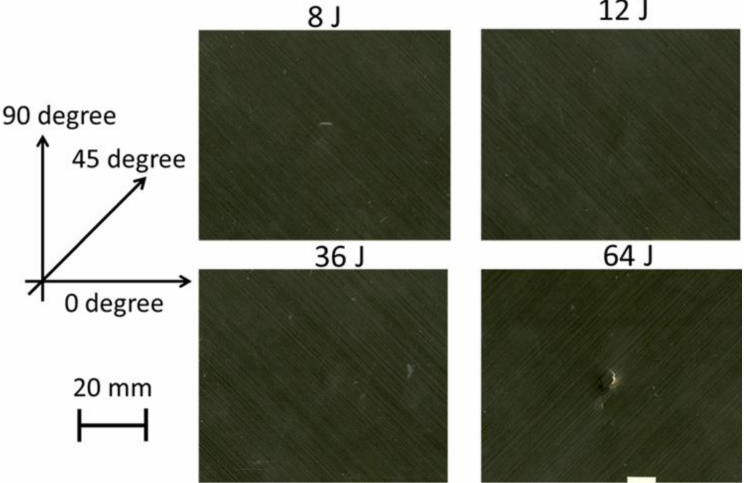
Figure 8. Images of samples that taken from the impacted surface at different impact energy levels using EPSON scanner.